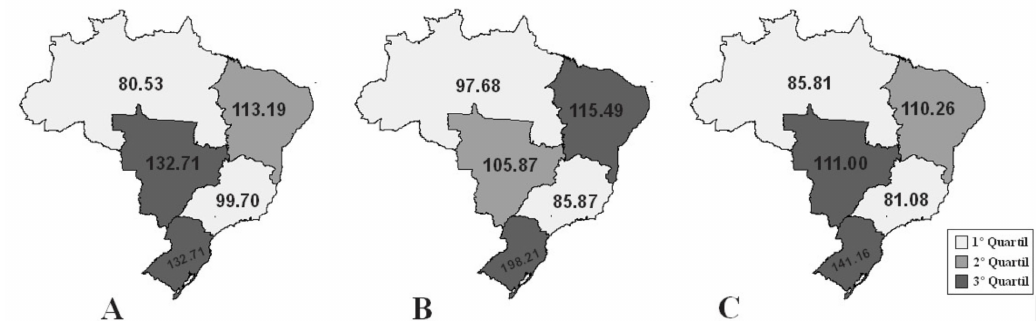
Figure 1. Quartiles of hospitalization rates for cervical cancer in the Brazilian regions in the periods observed. ( A ) 2000–2003;